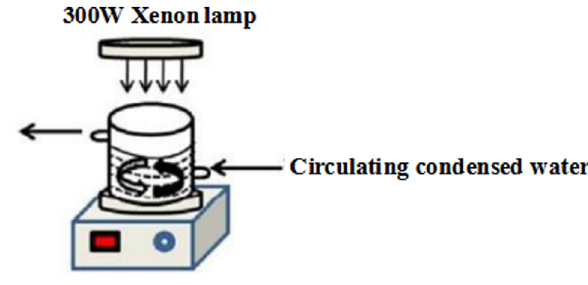
Figure 2: Photocatalytic reaction device.